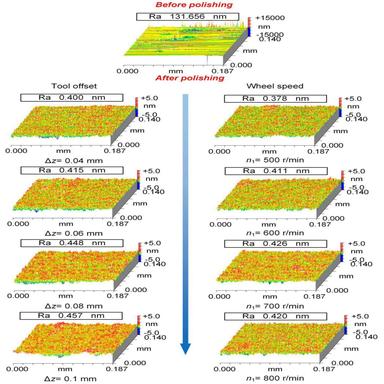
Surface topography of the Y-TZP bioceramic samples before and after polishing under different tool offsets and wheel speeds.